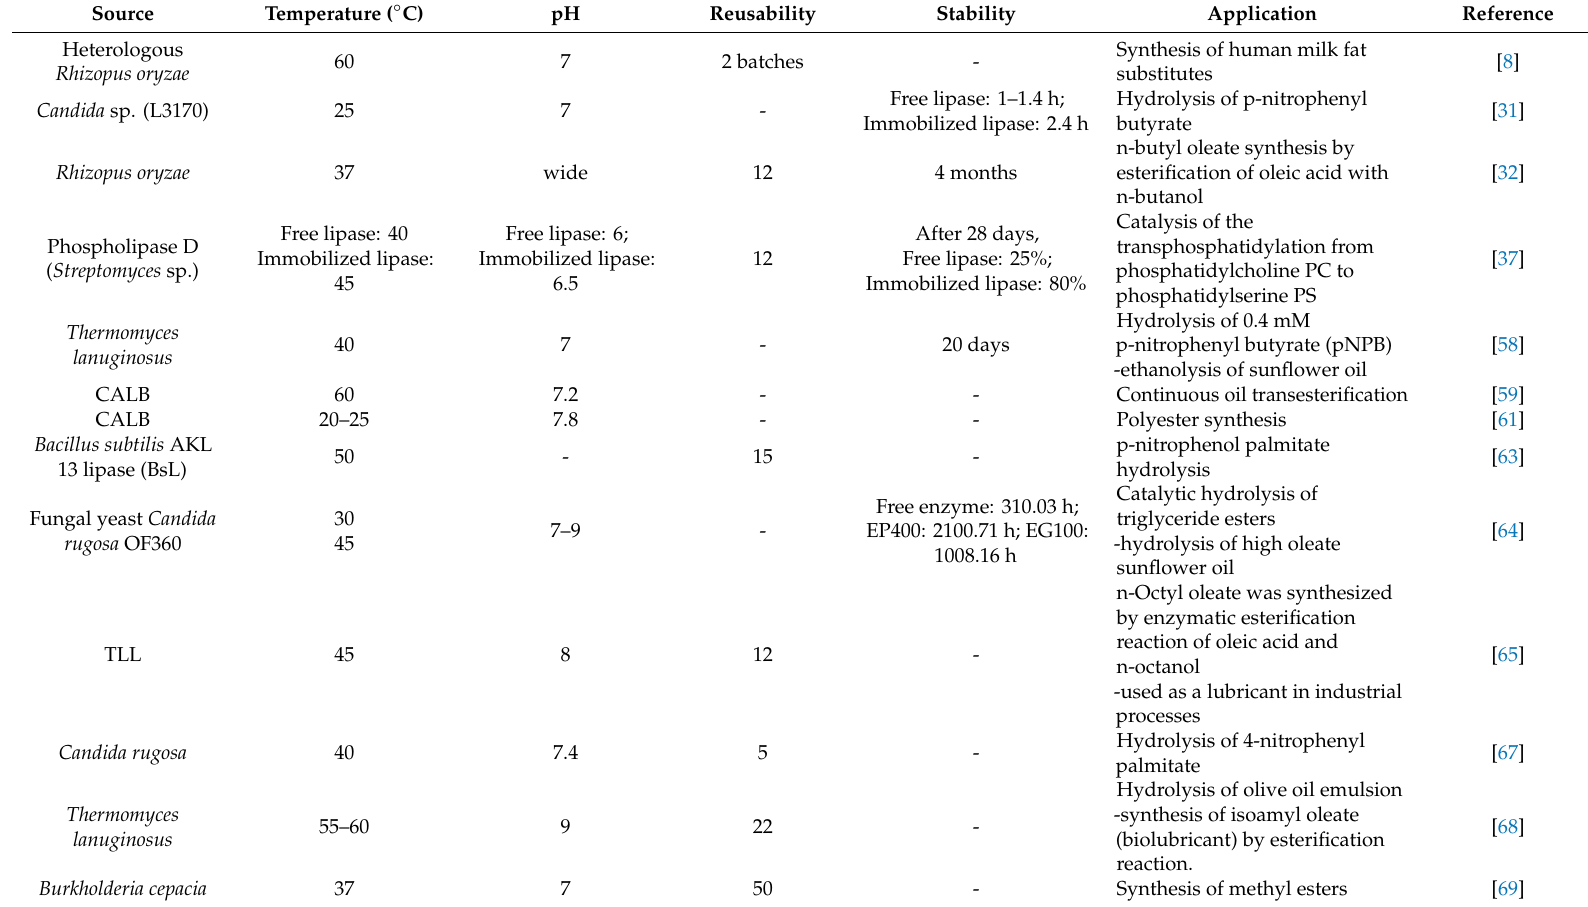
Table 3. Lipase immobilization on porous supports under optimum conditions for various